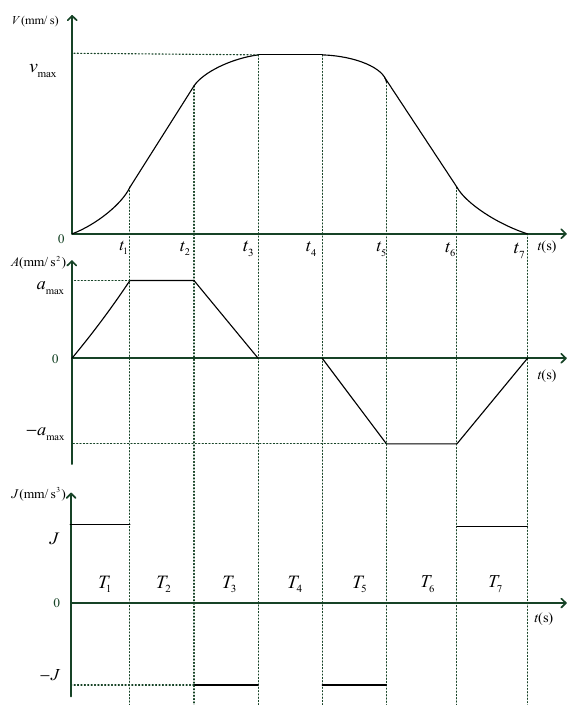
Figure 3. Seven-segment S-Velocity planning.